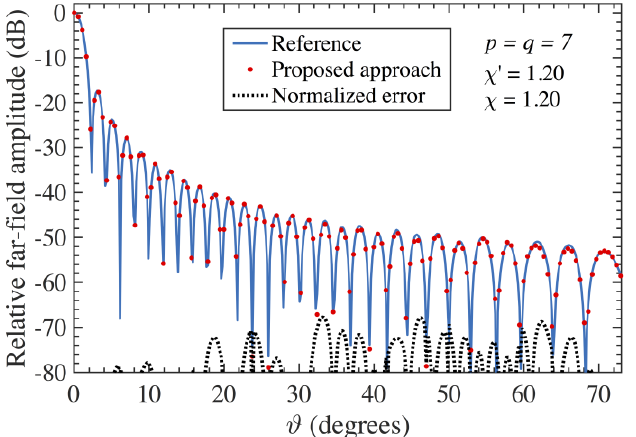
Figure 9. FF patterns in the E-plane—AUT 1. Blue line: reference. Red dots: attained from the posi- tioning errors affected PWMS samples by using the proposed procedure. Dashed line: corresponding normalized error.